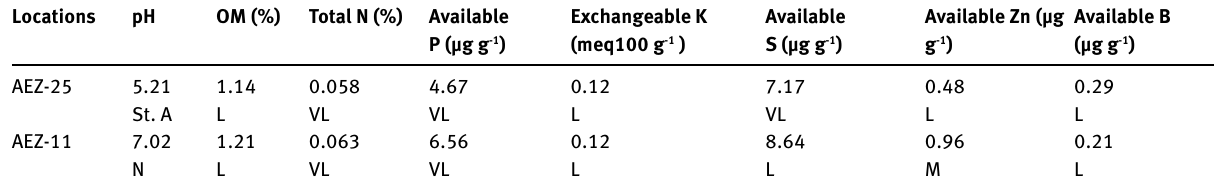
Table 1: Initial soil fertility status of experimental soils in two locations of Bangladesh (AEZ-25: Bogra; AEZ-11: Jashore)